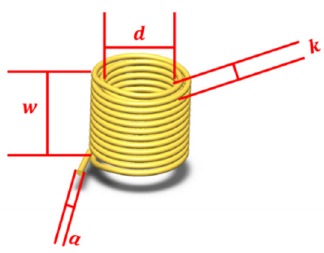
Figure 4. Schematic diagram of coil parameters.